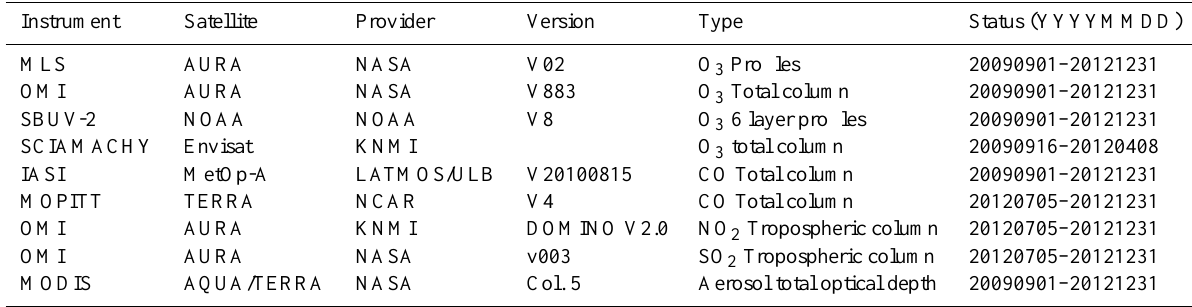
Table 1. List of assimilated data in the MACC_osuite. Instrument